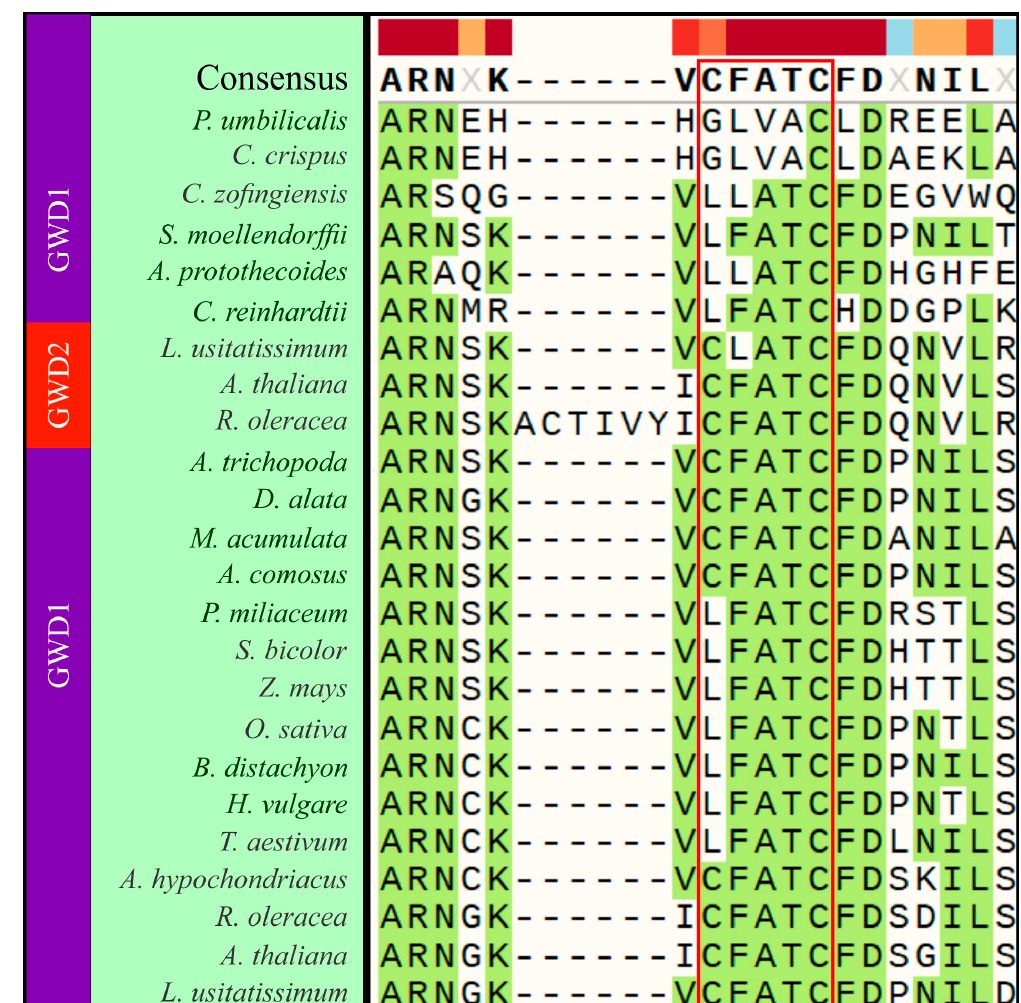
Figure 3. Substitution of amino acid residues in some plants at redox regulation motif (CFACT).